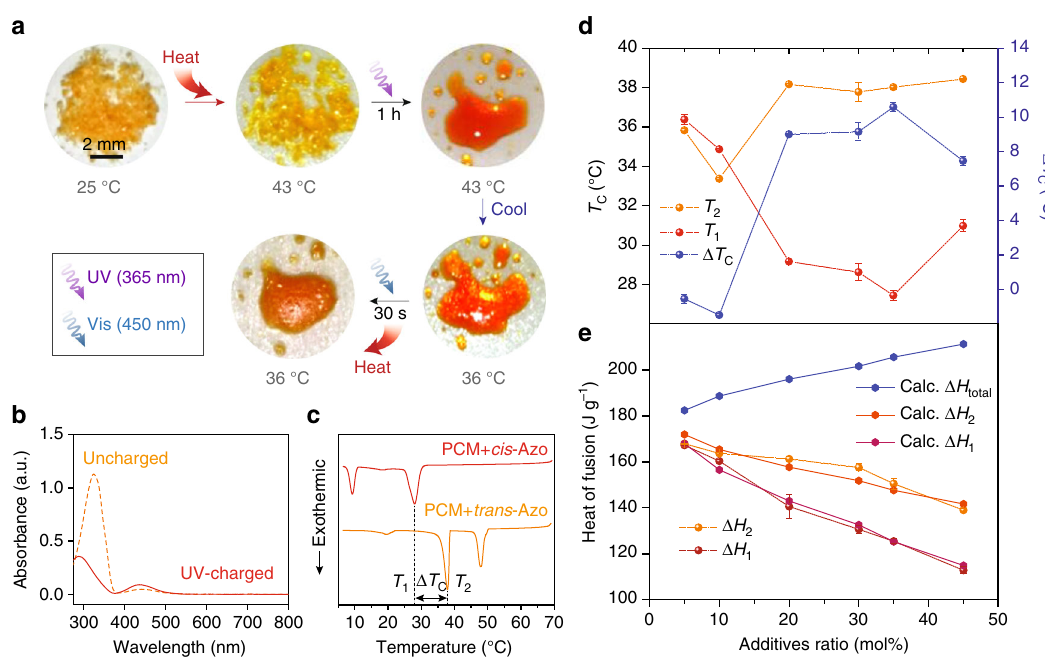
Fig. 2 Experimental observation of phase change and heat storage in composites. a Photographs of composites of tridecanoic acid and 30 mol% of azobenzene dopants during solid-state heat absorption/ UV charging/cooling/visible-light-induced discharging and heat-release process. b UV-vis absorption spectra of the azobenzene dopant in dichloromethane solution, before and after UV illumination. The uncharged solution is saturated with trans isomers (dotted yellow line), showing peak absorption at 325 nm ( π → π * transition), and the UV-charged solution saturated with cis isomers (solid red line) exhibits a n → π * transition peak at 440 nm 48,49 . c Differential scanning calorimetry (DSC) scans of charged and uncharged composites (35 mol% doped) obtained while cooling from 70 °C at a rate of 5 °C min − 1 , illustrating different crystallization points ( T 1 and T 2 ) and the gap ( Δ T c ). Small peaks at 20 °C indicate the solidi fi cation of a minor polymorph 50 in tridecanoic acid. d T 1 , T 2 (left axis), and Δ T c (right axis) measured by DSC at a rate of 5 °C min − 1 from composites with varying additive ratios. e Heat of fusion (i.e., crystallization enthalpy) measured by DSC at a rate of 5 °C min − 1 and calculated on the composites with varying additive ratios. Error bars in d , e indicate standard deviations of the data (either temperature or heat of fusion) collected at least 5 times on each type of